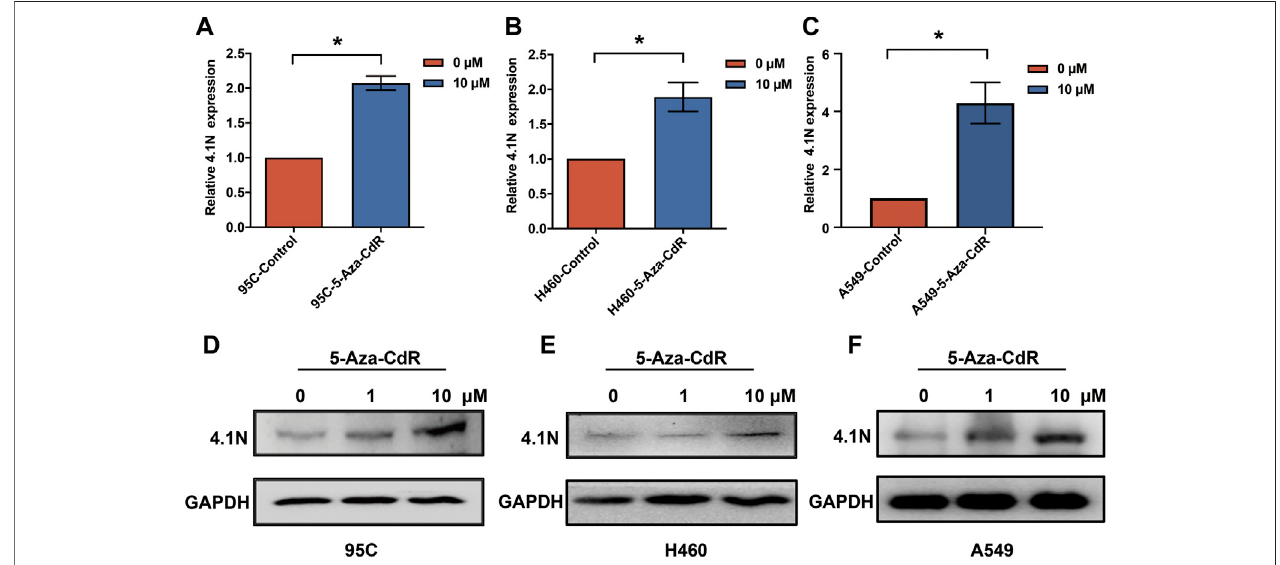
FIGURE 2 | 4.1N/ EPB41L1 was restored by methyltransferase inhibitor 5-Aza-CdR in NSCLC cells. (A – C) qPCR was performed to evaluate expressions of 4.1N/ EPB41L1 mRNA in 95C, H460, and A549 cells after 0 μ M or 1 μ M 5-Aza-CdR treatments for 48 h (D – F) 95C, H460, and A549 cells were treated with 0, 1 or 10 μ M 5- Aza-CdR for 48 h, and then the protein was detected by Western blot. The data were presented as the mean ± SD, * p < 0.05.